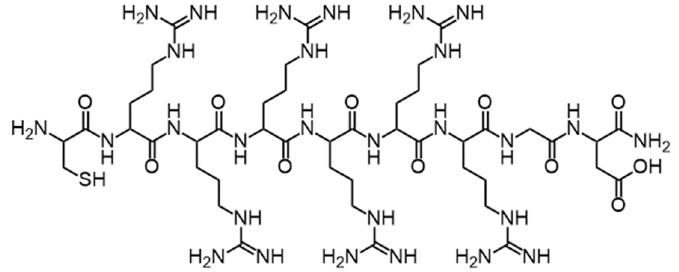
Figure 2. Schematic structure of the cationic peptide